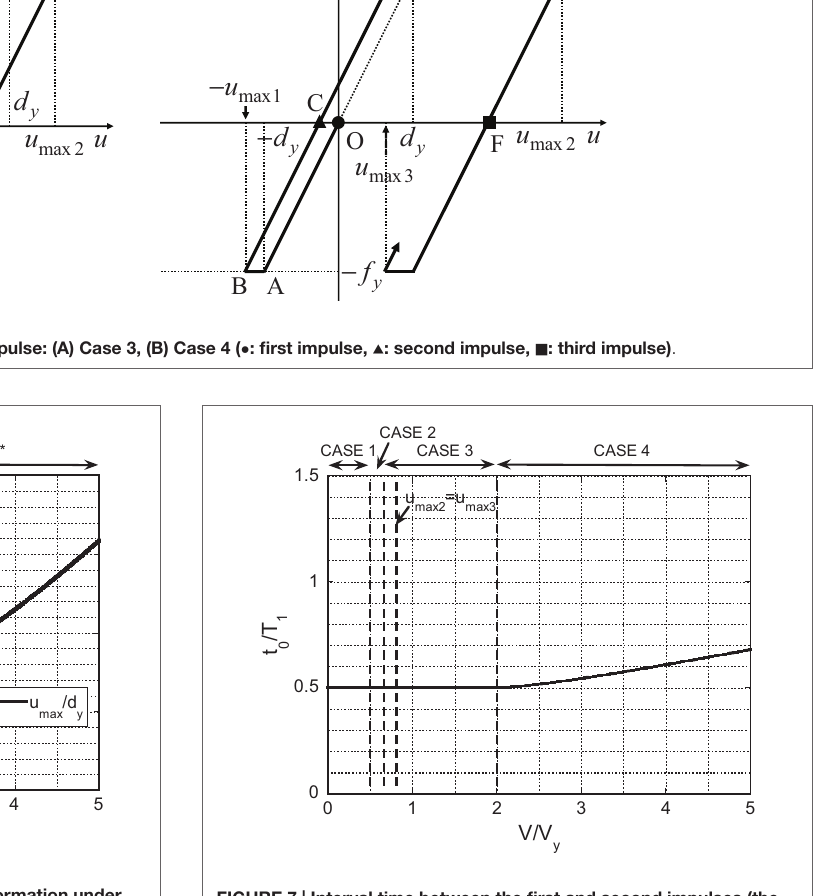
FigUre 7 | interval time between the first and second impulses (the second and third impulses) with respect to input level .